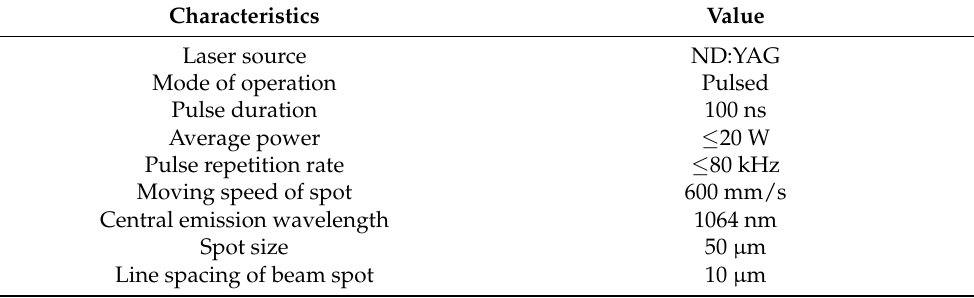
Table 1. Optical characteristics of ytterbium pulsed fiber laser beam.